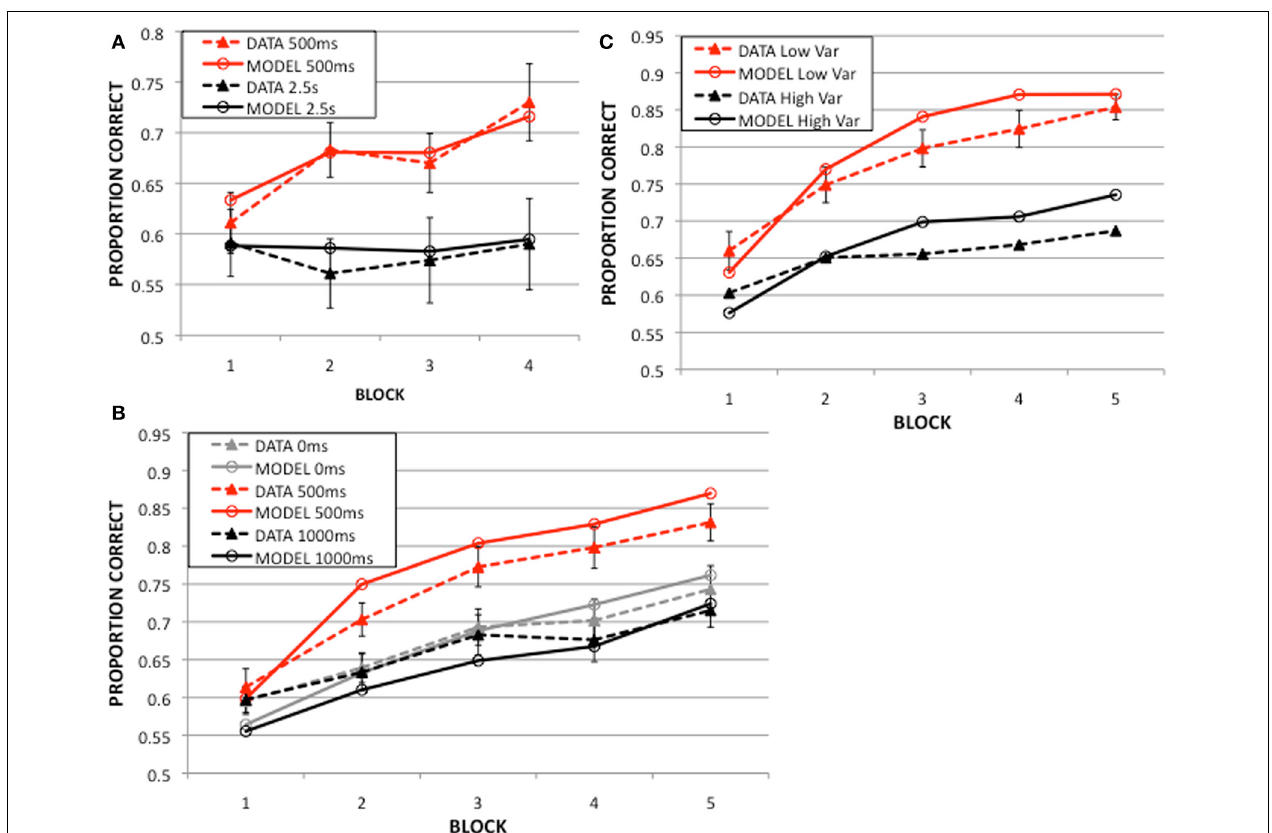
FIGURE 4 | Dynamic procedural category learning model results from 50 simulations of: (A) 2003 Experiment: feedback delay of 500ms yields much better learning than that of 2.5s. (B) 2013 Experiment 1: learning is best at